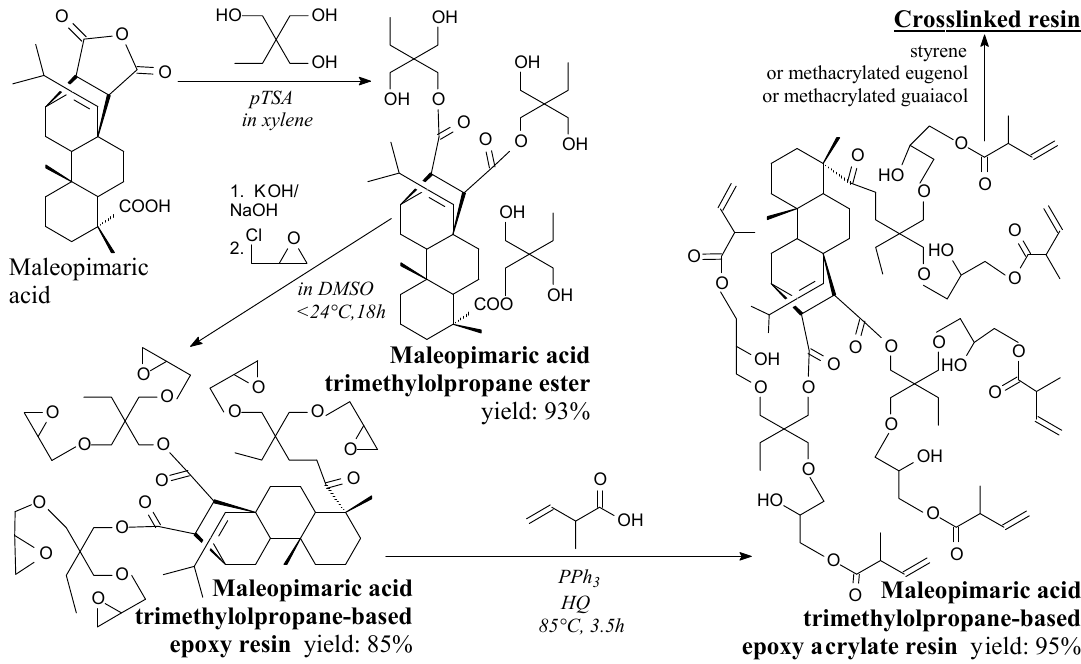
Scheme 10. Preparation of maleopimaric acid-trimethylolpropane ester-based epoxy acrylate resin crosslinked by unsaturated monomers.